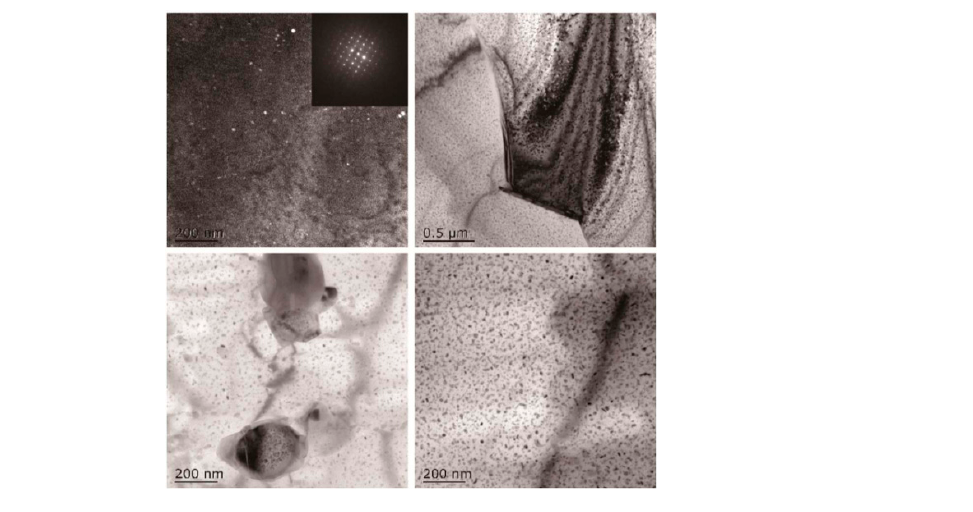
Figure 13. TEM topographic images of Al-0.25Y-0.25Sc alloy after aging. Adapted with permission from ref. [67]. 2018 Yan et al.